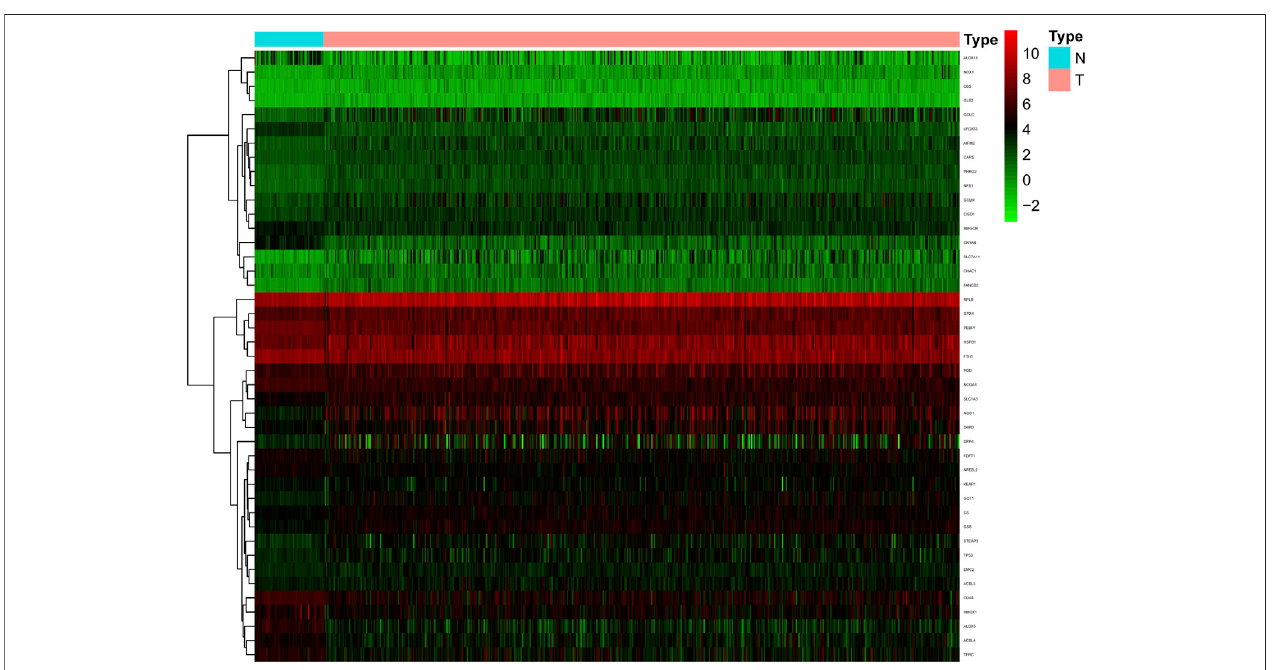
FIGURE 1 | The heatmap of differentially expressed ferroptosis-related genes in the TCGA cohort. Compared with normal samples, a total of 29 up-regulated and 14 down-regulated ferroptosis-related genes were screened in tumor samples.